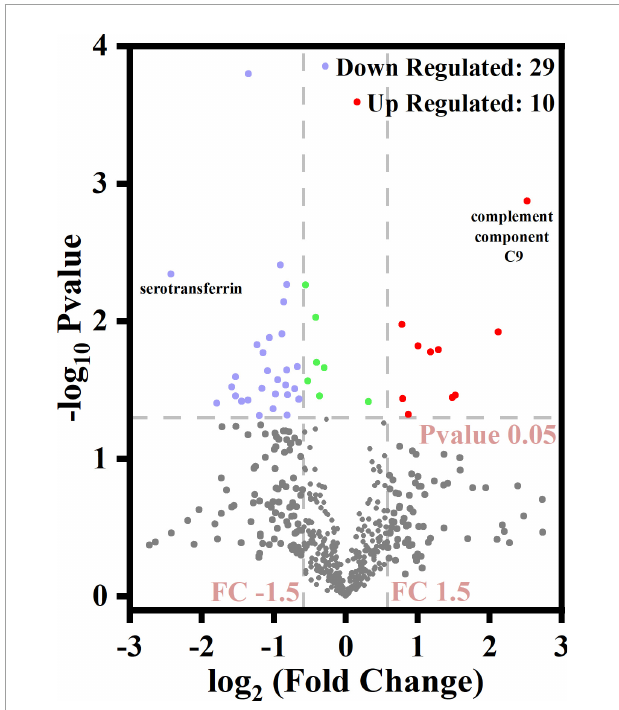
FIGURE4 Volcano diagram for differentially expressed caseins from Korean and Han ethnic groups in China.